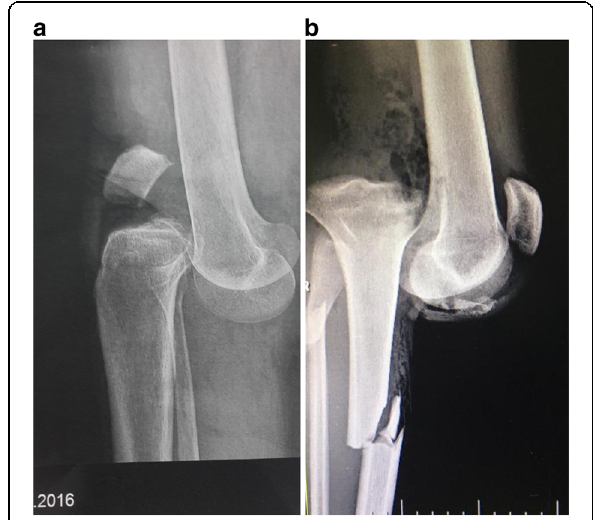
Fig. 1 a knee dislocation KDIV. b Knee dislocation